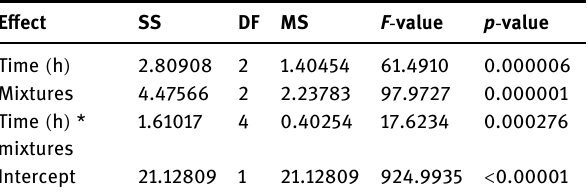
Table 7: Analysis of variance ( ANOVA ) for apparent viscosity results